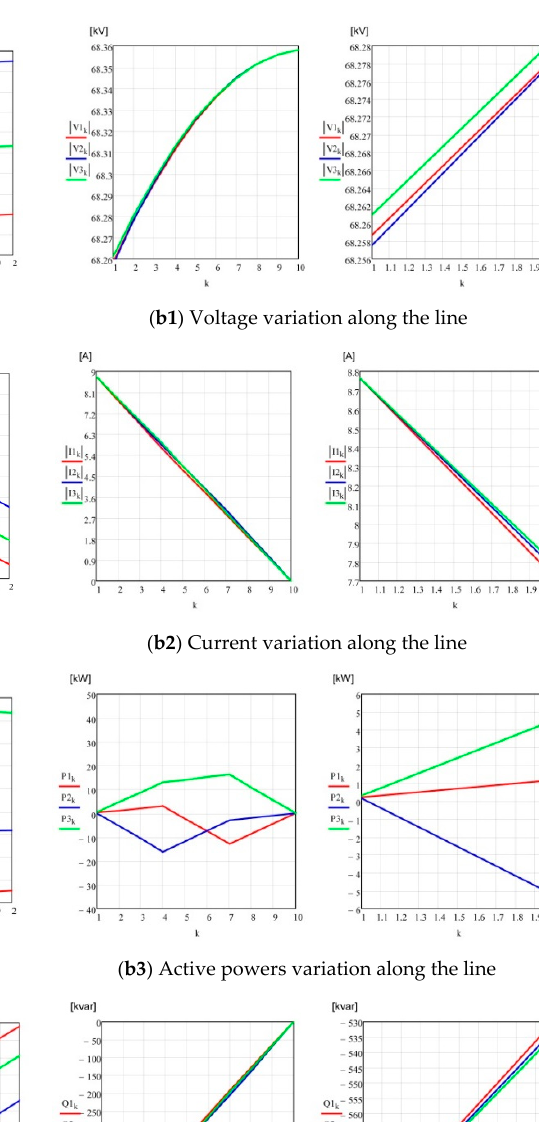
12 of 17 The equations between phase currents and phase voltages (between phases and ground conductors), depending on the phase total impedances and admittance matrices, are as follows: (cid:3427)𝑰 (cid:3028)(cid:3029)(cid:3030) (cid:3431) = (cid:3427)𝑰 (cid:3028)(cid:3029)(cid:3030)(cid:4593) (cid:3431) + (cid:3427)𝒀 (cid:3028)(cid:3029)(cid:3030) (cid:3431) ∙ (cid:3427)𝑽 (cid:3028)(cid:3029)(cid:3030) (cid:3431) (21) (cid:3427)𝑽 (cid:3028)(cid:3029)(cid:3030) (cid:3431) = (cid:3427)𝑽 (cid:3028)(cid:3029)(cid:3030)(cid:4593) (cid:3431) + (cid:3427)𝒁 (cid:3028)(cid:3029)(cid:3030) (cid:3431) ∙ (cid:3427)𝑰 (cid:3028)(cid:3029)(cid:3030) (cid:3431) . (22) Equations (21) and (22) allow for the back forward power flow calculation. In the case of long OHLs or situations where the variation of the values of electrical amounts along the line are monitored, it should be divided into segments of small lengths, which are modeled by appropriate equivalent octopoles. The limit of two successive octopoles correspond to the sections of the line where the values of electrical amounts are monitored. 5. Power Flow Calculation for the Studied OHL and Comparison with Measured Values Mathematical modeling in the phase coordinates of the no-load operating conditions of the studied OHL was performed in order to determine if the paradox described above can be achieved. For this purpose, the values of the previously calculated phase parameters were used. In order to determine the variation in electrical amounts along the line, modeling was achieved by dividing it into nine segments of equal length, which highlight the 10 sections. Each of the nine segments was modeled by an equivalent octopole with concentrated parameters. Then, Equations (21) and (22) were successively applied for the back forward power flow calculation (section k = 10—the end of the line to section k = 1—the beginning of the line). For each section the voltages, currents, and active and reactive powers were determined. In the second part of the numerical study, a hypothetical transposition of the line was considered to evaluate the effect of this operation and to verify the correctness of the mathematical model. For this purpose, two permutations of the three-phase conductors were considered, and they were done in Sections 4 and 7, respectively. The line was thus divided into three parts of equal length (each containing three out of the nine equal segments) without considering the tower’s position in the field. Phase conductors’ permutations were introduced into the calculus by appropriate permutations in matrices D (distances between the four conductors’ matrix) and S (distances between the conductors and their images’ matrix). Figure 7 presents the results of the electrical amounts obtained by numerical calculation in the two situations: the non-transposed line (a1–4)), and the transposed line (b1–4), respectively.